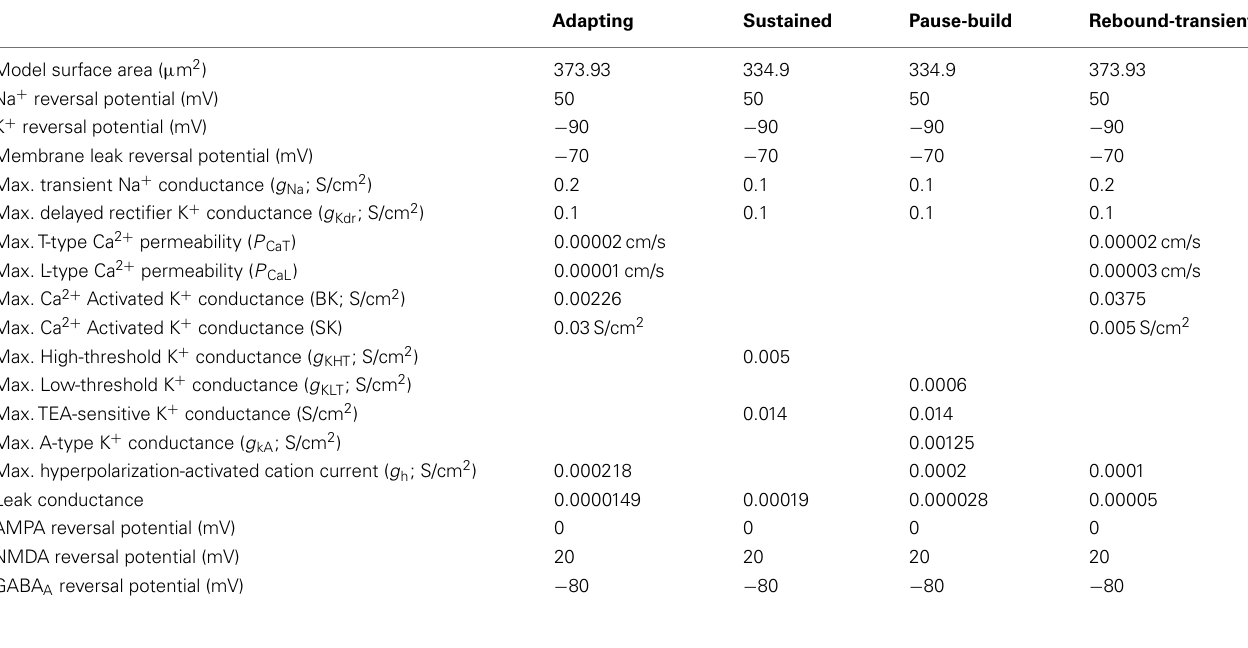
TableA1 | Model parameters for sustained, adapting, pause-build, and rebound-transient patterns